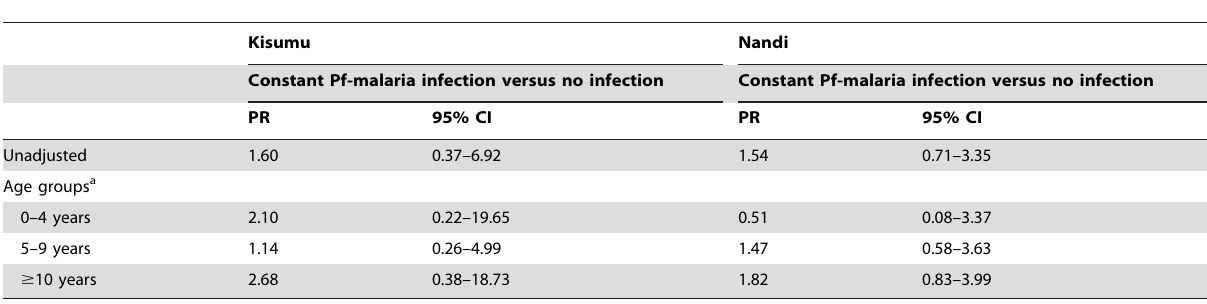
Table 4. Prevalence Ratio for EBV Latent Antigen CD8 + T-cell IFN- c Response.